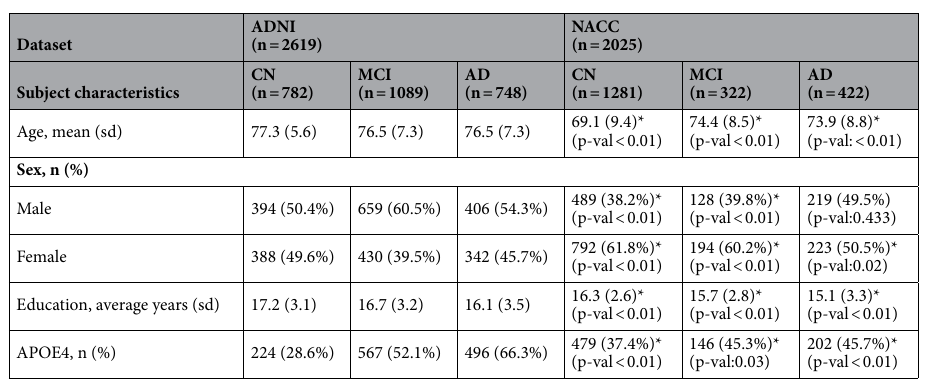
Table 1. Demographic characteristics of the ADNI and NACC cohorts. Significance of differences between NACC and ADNI for each cognitive category are reported. Statistical significance (at p-value < 0.05) is indicated by